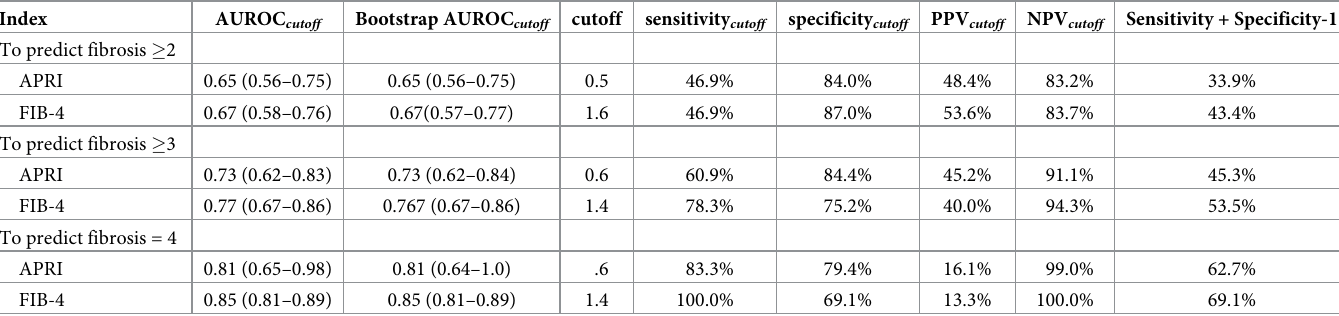
Table 3. Diagnostic accuracies of APRI and FIB-4 for predicting liver fibrosis (AST (cid:20) 37 IU/L, N = 132). Index AUROC cutoff